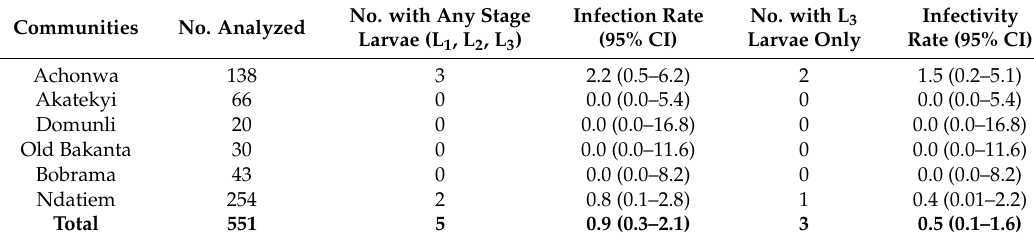
Table 8. W. bancrofti infection and infectivity rates in An. gambiae in selected study